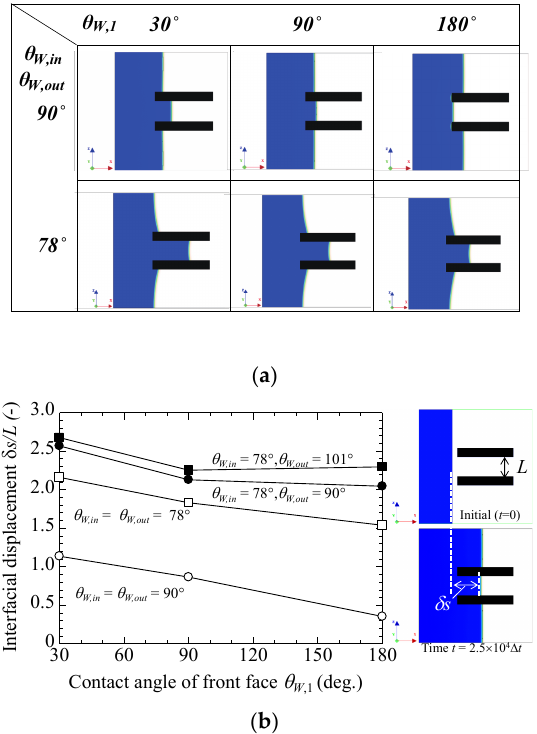
Figure 2. Penetration effect due to different contact angles, θ W,out , θ W,in , and θ W,1 . ( a ) Snapshots for time, t = 25,000 ∆ t. ( b ) Interfacial displacement, ∂ s/L , as a function of contact angle of front face, θ W,1